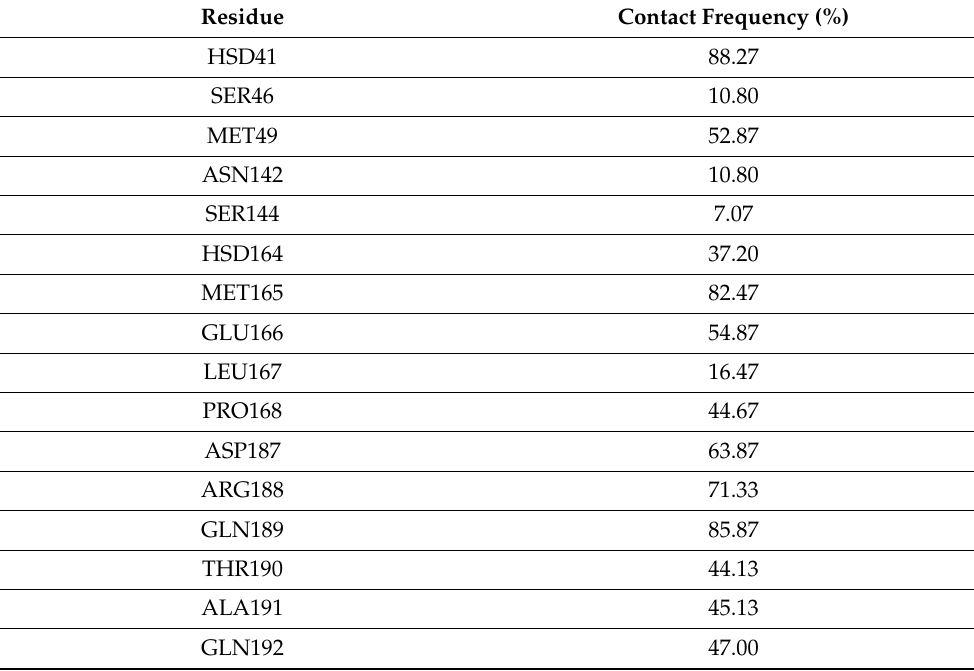
Table 7. Contact frequency analysis in the MD